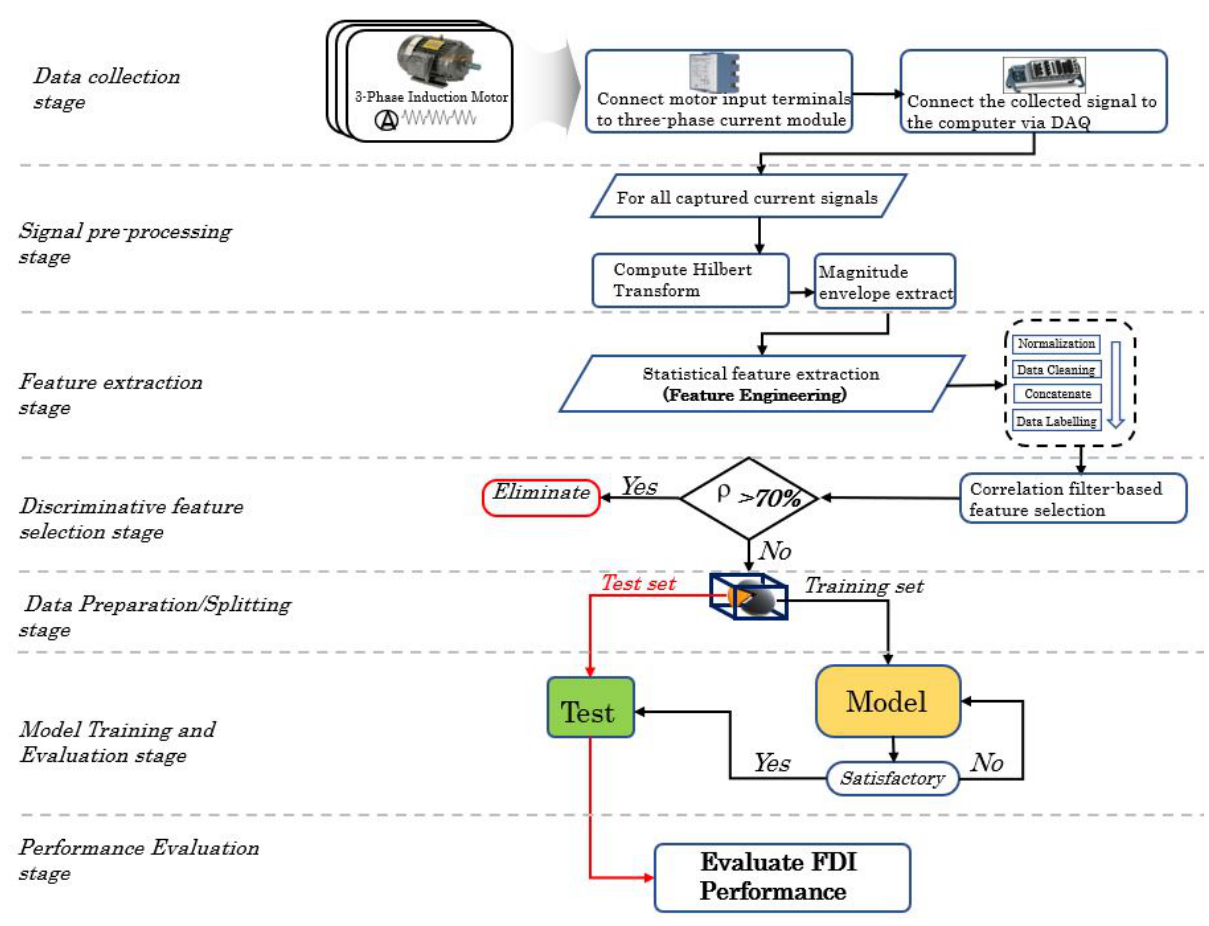
Figure 4. The flow chat of the filter-based model.